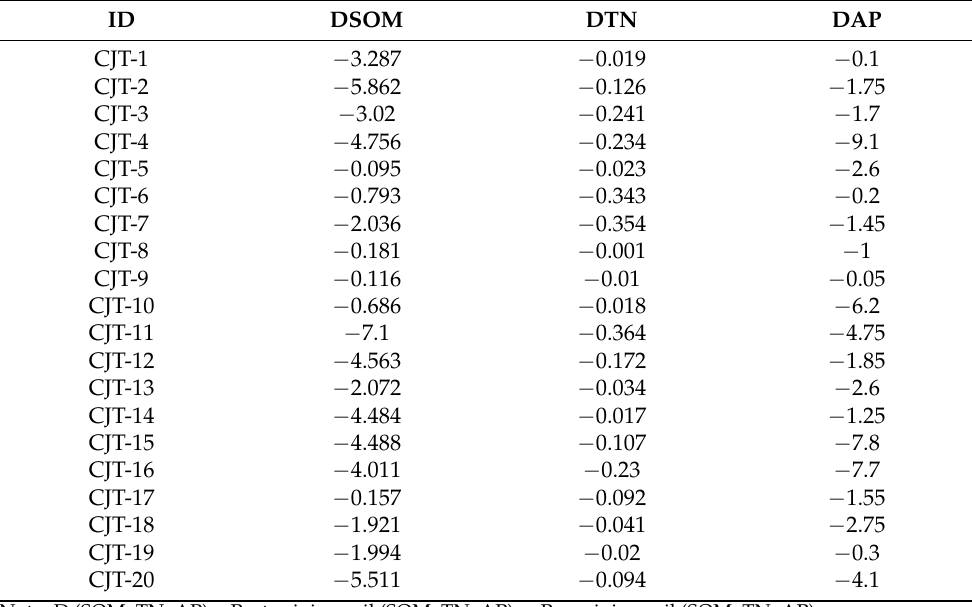
Table 2. Soil nutrients loss after mining